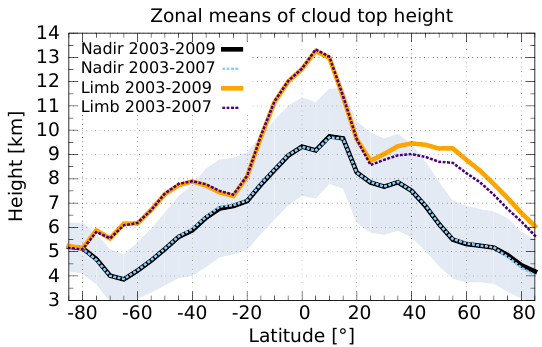
Figure 13. SCODA zonal mean CTH averaged over 5 (2003–2007, violet dashed line) and 7 (2003–2009, orange line) years. The gap in the Northern Hemisphere between both curves shows the influence of the volcanic eruptions in 2008 and 2009 on the retrieval results. The corresponding SACURA nadir zonal means (blue dashed and black line) and the 1 σ intervals (grey area) are